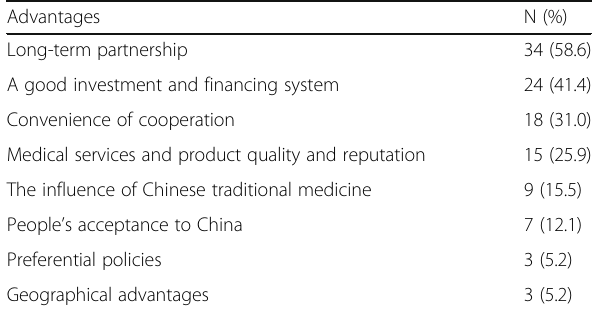
Table 3 Contents of participation in BRI Health Cooperation